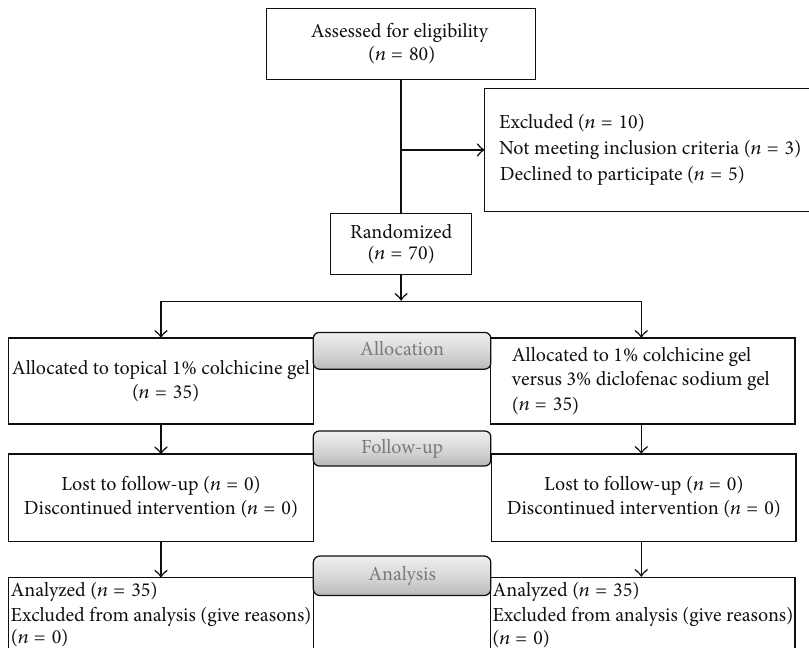
Figure 1: CONSORT flow diagram: topical 1% colchicine gel versus 3% diclofenac sodium gel for the treatment of actinic keratosis.